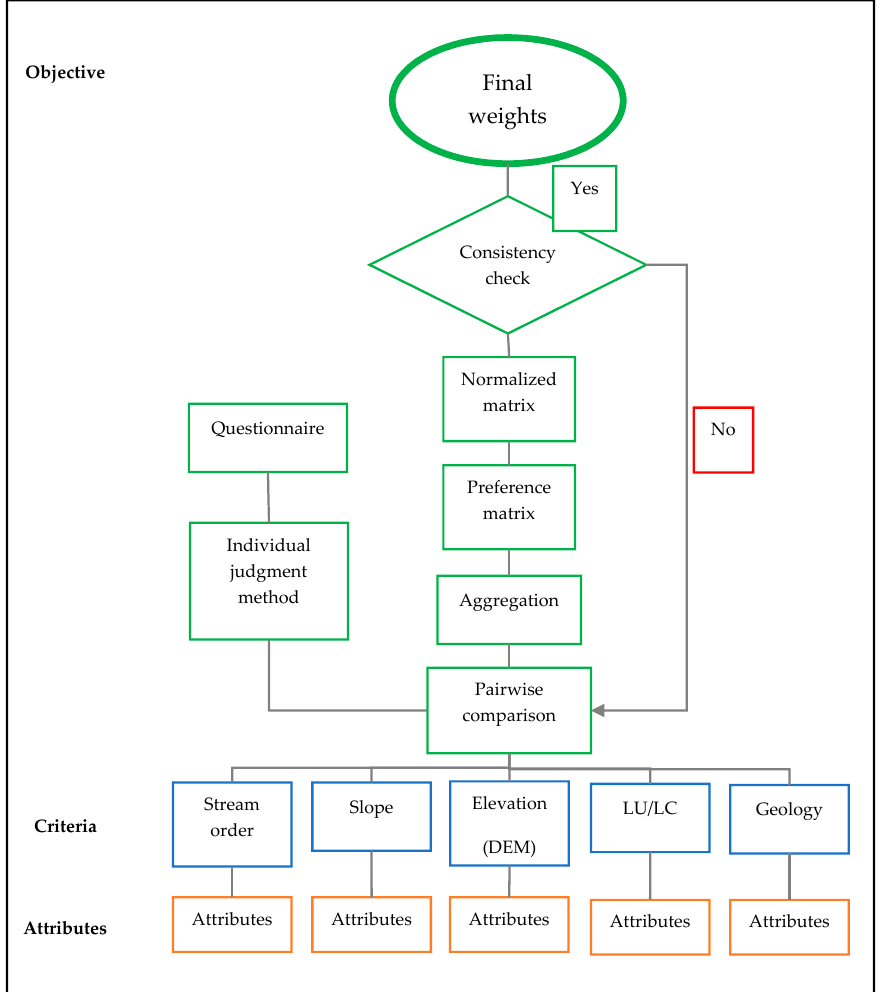
Figure 9. Analytic hierarchy process (AHP) as weighting method.